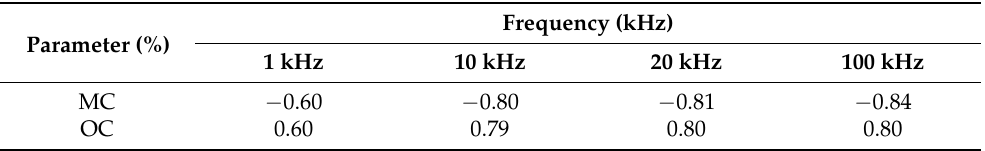
Table 4. Correlation coefficient ( r ) of impedance with moisture and oil content at four frequencies using the Pearson correlation method.